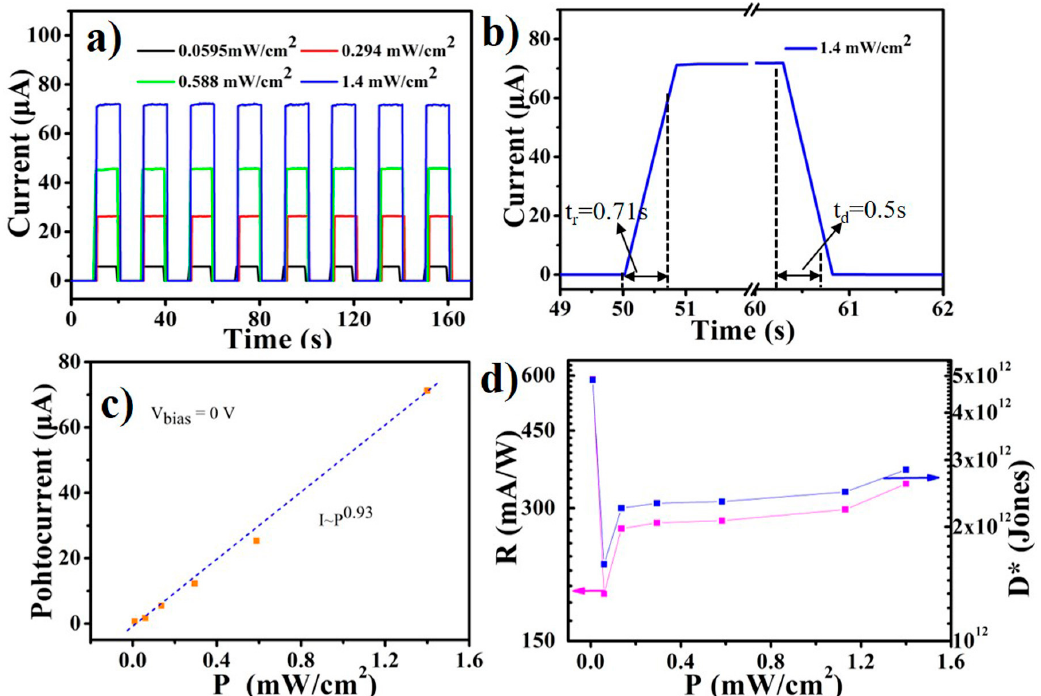
Figure 5. ( a ) Time-dependent on / off switching of the device with different power density light illumination. ( b ) The response time of the device under 1.4 mWcm − 2 light illumination. ( c ) Power-density-dependent photocurrent and its corresponding fitting curve. ( d ) Power-density-dependent responsivity and specific detectivity. All the tests were carried out at 0 V bias and used 365 nm light illumination.